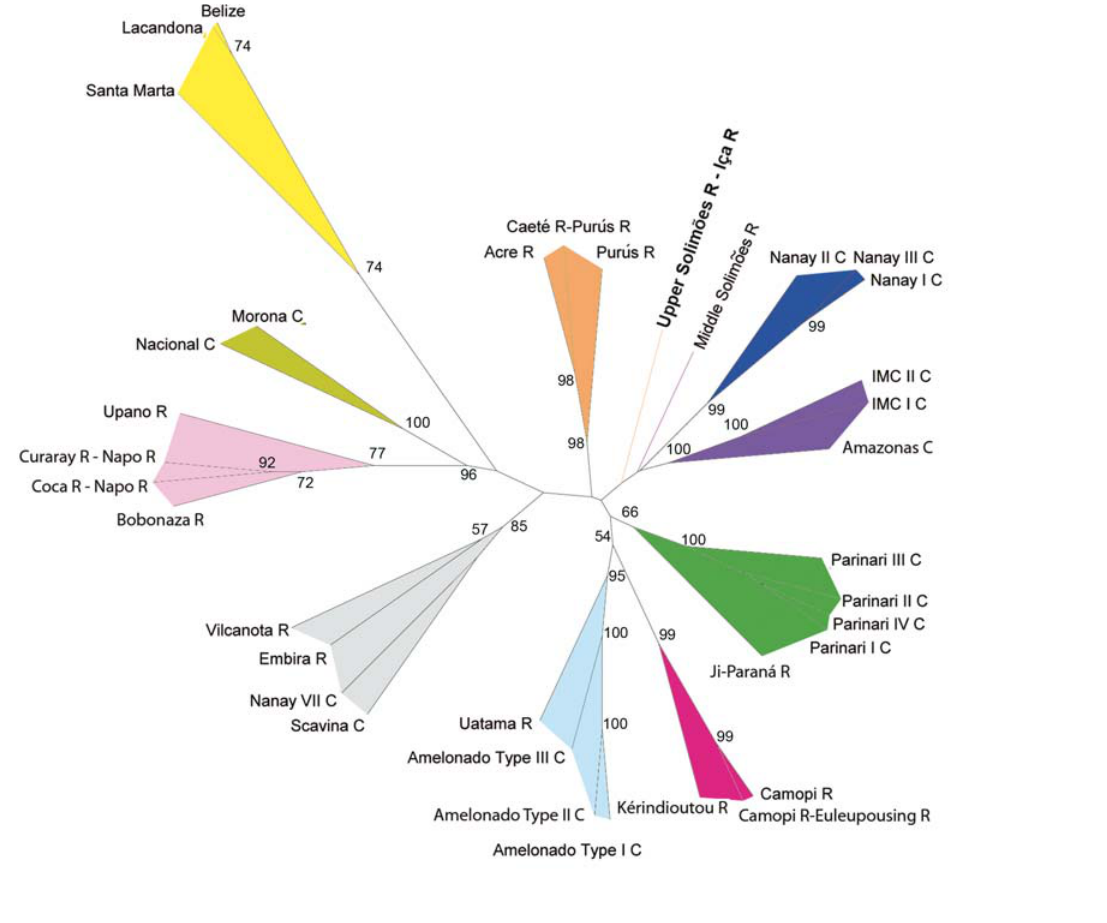
Figure 2. Neighbor joining tree from Cavalli-Sforza and Edwards genetic distance [ 16 ] matrix among the 36 subclusters identified using Structure (559 clones). Values represent percentages after bootstraps on the 96 loci retained.